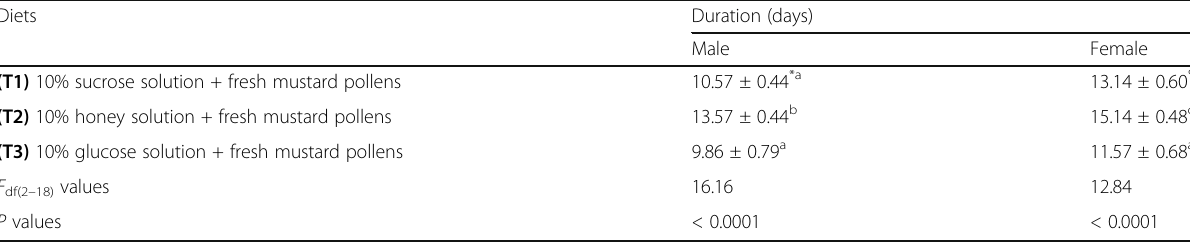
Table 3 Longevity of Episyrphus balteatus on different diets Diets Duration (days)